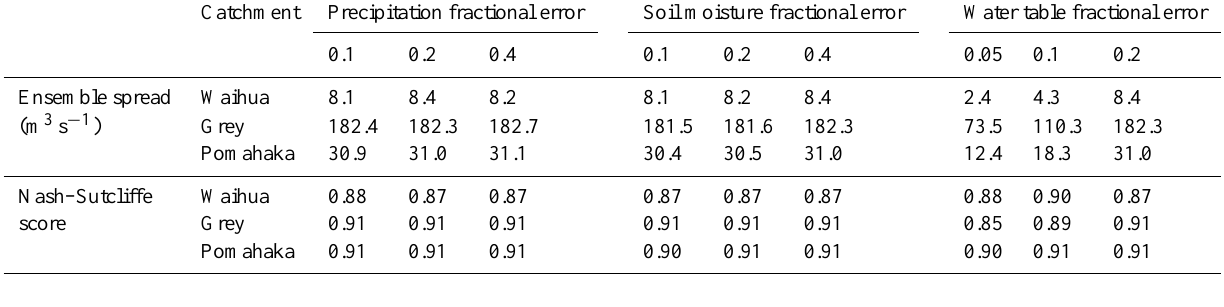
Table 5. The effect of fractional error parameters on ensemble spread and Nash–Sutcliffe performance score under the REnKF, for selected catchments during a 6 month simulation period 31 March 2011–31 September 2011.